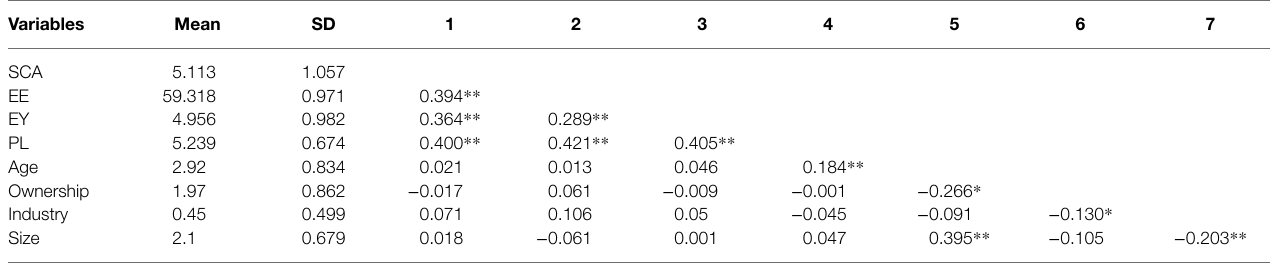
TABLE 2 | Summary statistics and correlation matrix.